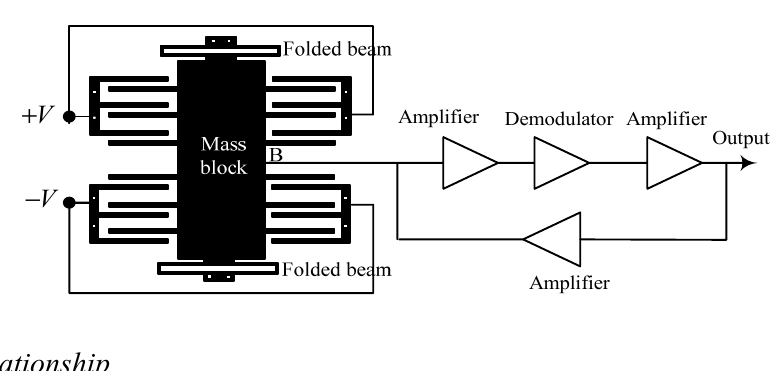
Figure 4. Diagram of an